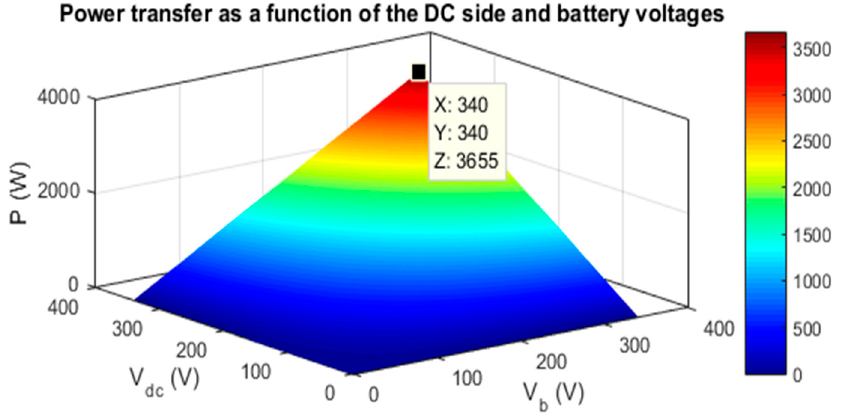
Figure 11. Evolution of the power transfer as a function of the DC side and battery voltage for a fixed mutual coupling.